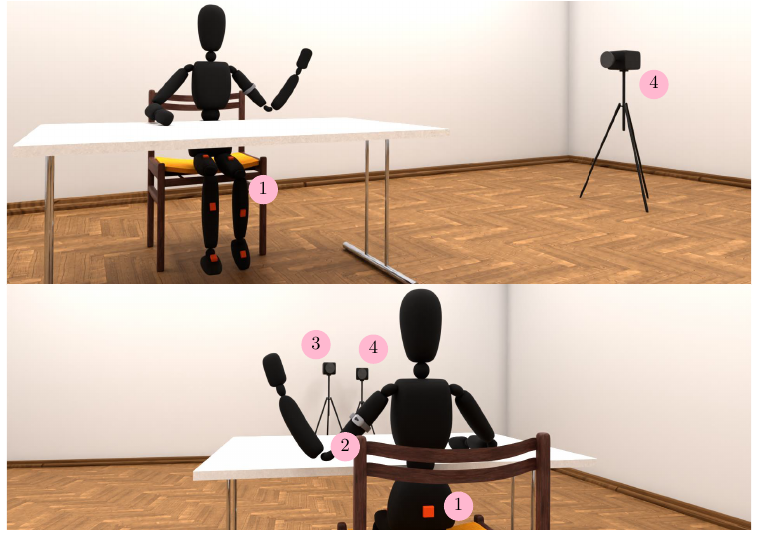
Figure 2. Measuring system with measuring instruments: 1—IMU, 2—SenseWear sensor, 3—thermal imaging camera, 4—(RGB) video